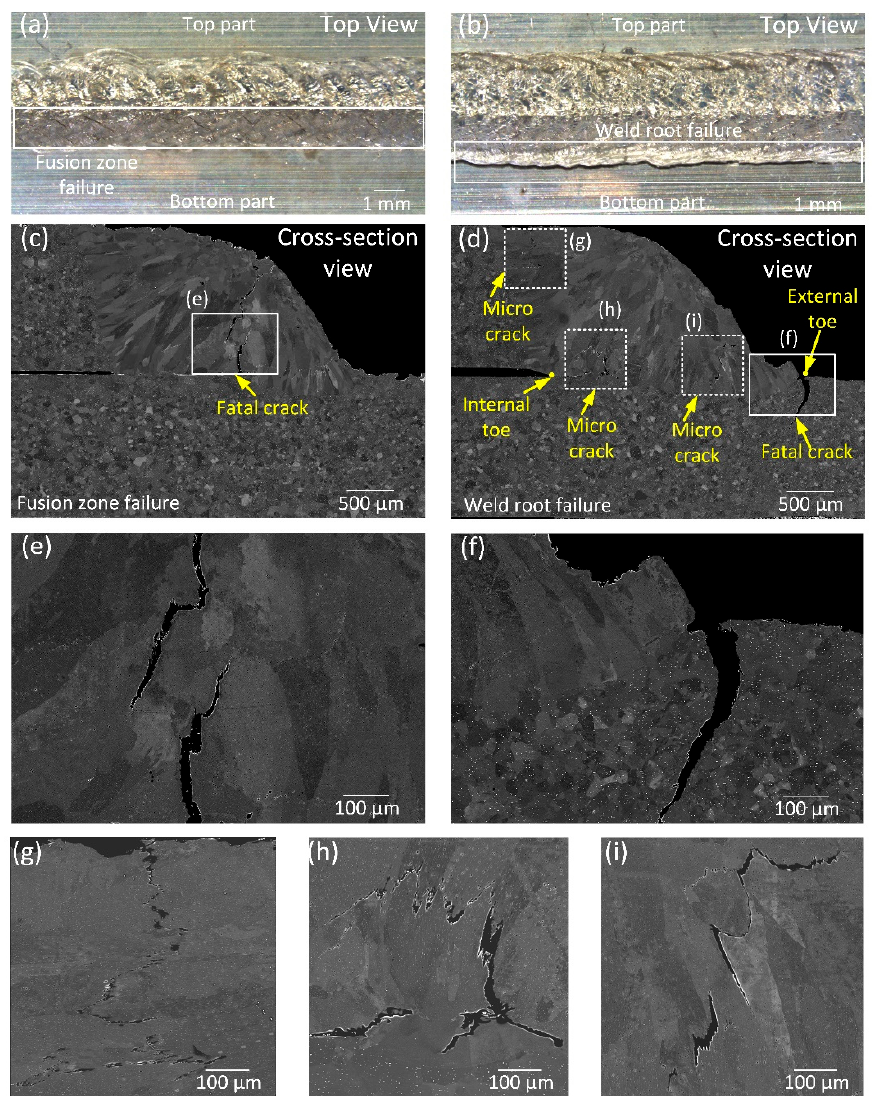
Figure 12. Representative top view ( a , b ) and cross section view ( c , d ) of fatigue failure in fusion zone and weld root respectively with detailed view near the fatigue fatal crack in ( e , f ). ( g – i ) show the high magnification view of transverse micro crack in positions addressed in ( d ). ( a , c ) were obtained from S6-F150 at P B = 5.57 kW. ( b , d ) were obtained from S2-F50 at P B = 3.25 kW.